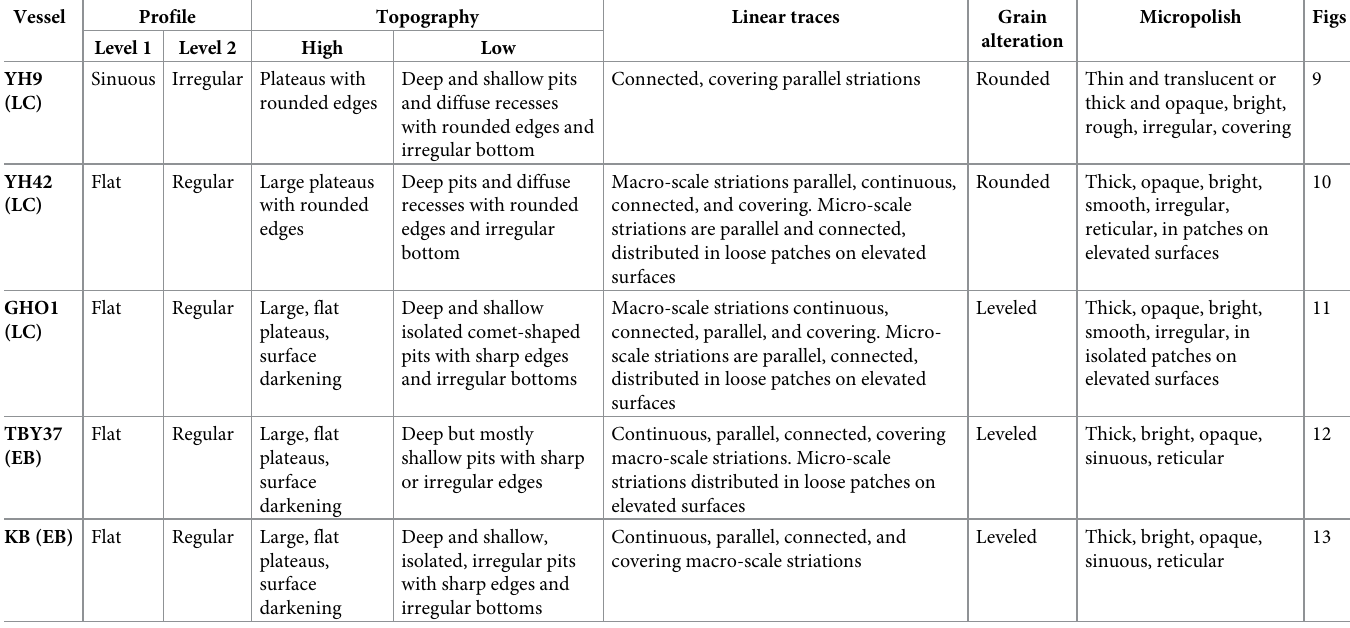
Table 5. Description of the traces observed within the circumferential depression of each of the five archaeological vessels analyzed for